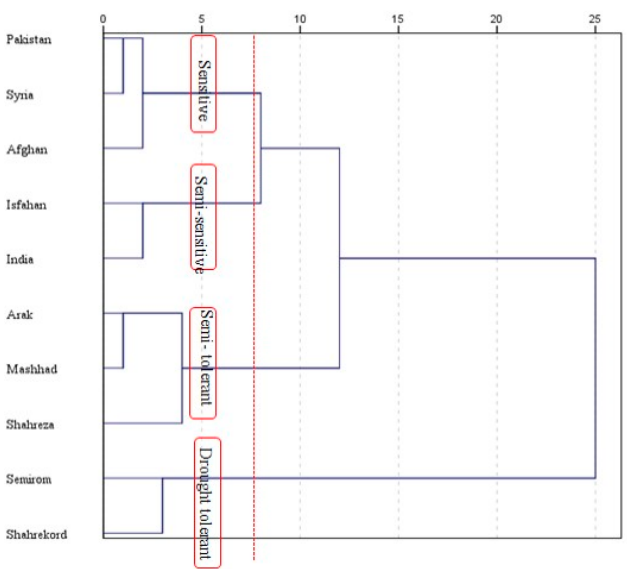
Figure 2. Dendrogram of 10 genotypes of black cumin based on the means of proline, TSC, RWC, H 2 O 2 , MDA, and SSI. Data collected from 2017 to 2018 and using Ward clustering.